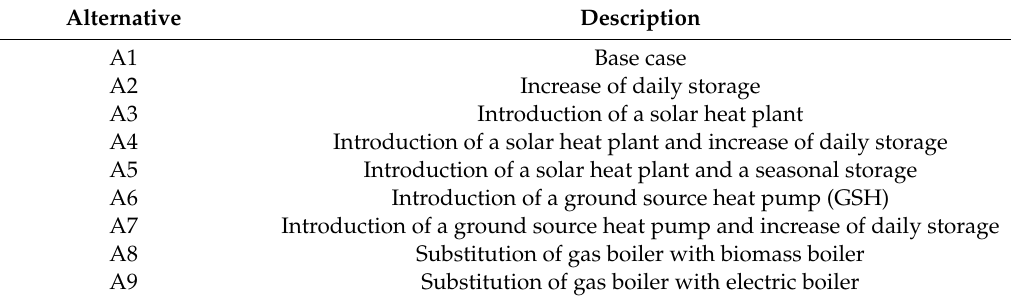
Table 2. Set of alternative scenarios.